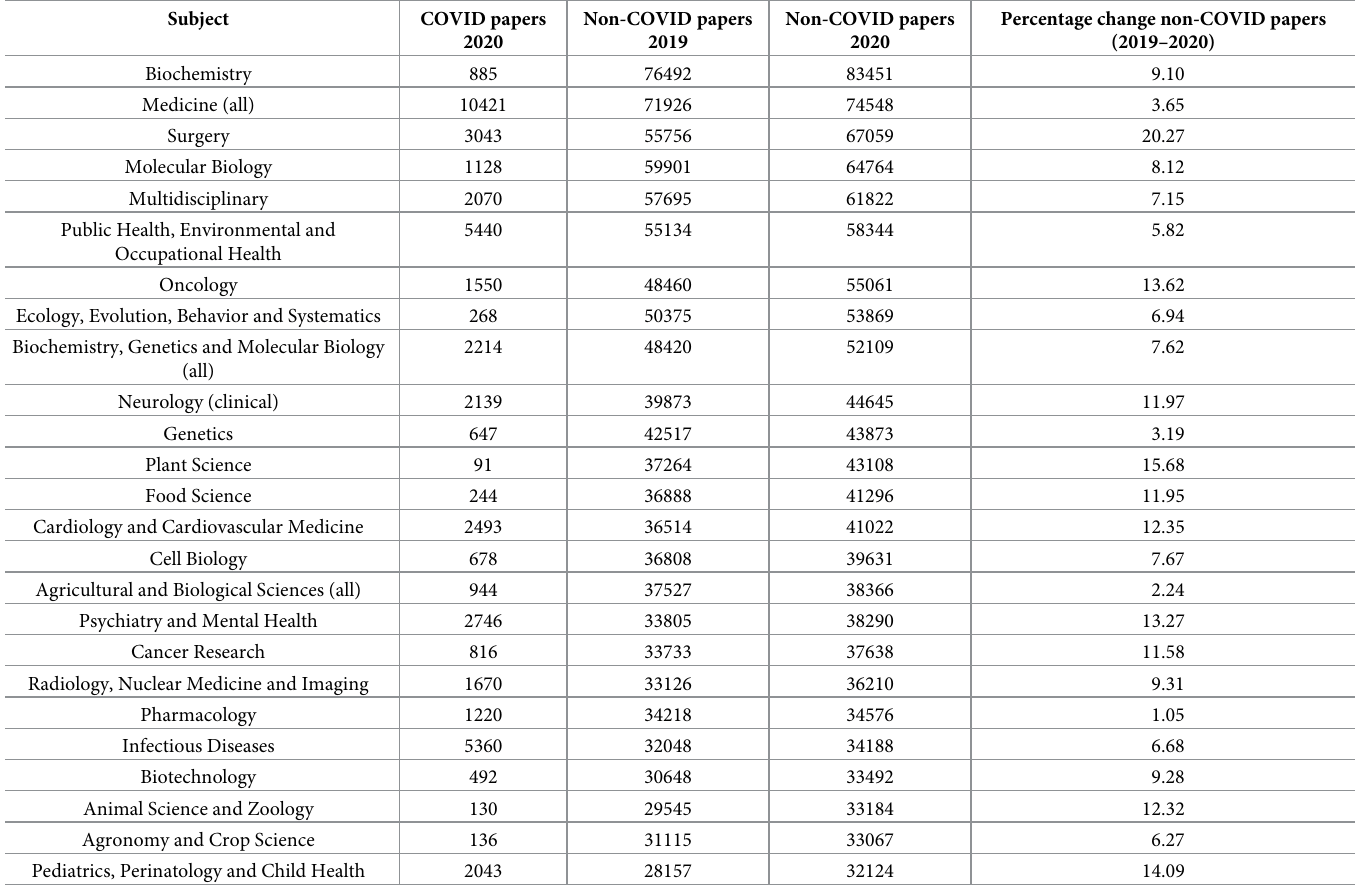
Table 2. Top 25 fields publishing research on COVID and non-COVID topics. Data: Elsevier’s